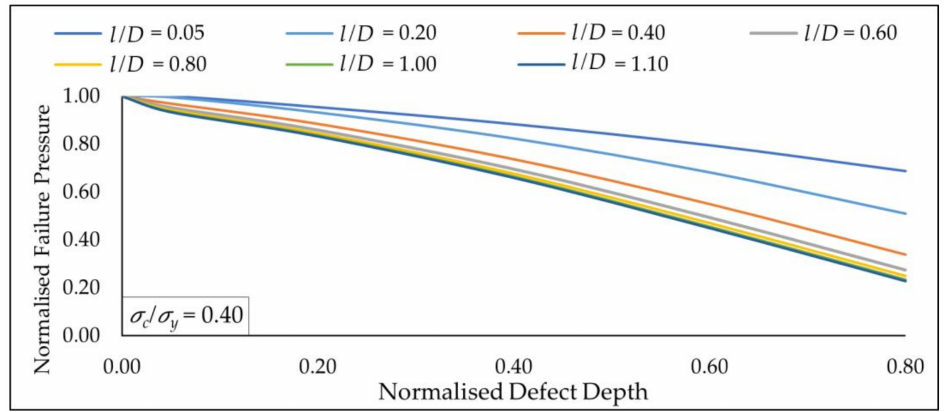
Figure 20. Normalized failure pressure predictions of the new assessment method against various normalized defect depth for multiple normalised defect lengths at a constant normalized axial compressive stress of 0.40.